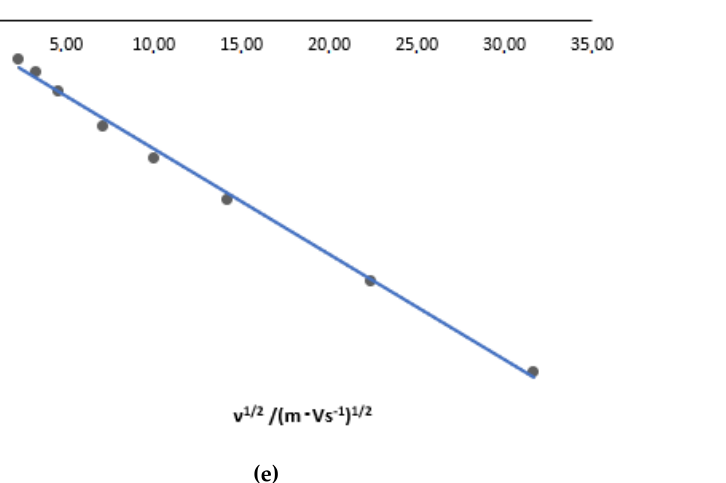
Figure 5. ( a ) Cyclic voltammograms of 1 × 10 − 3 mol dm − 3 Bi(III) at different scan rates recorded in 1 mol dm − 3 chlorate(VII) solution in the absence of the methionine. The scan rate ( v ) values are given on the plots. ( b ) Cyclic voltammograms of 1 × 10 − 3 mol dm − 3 Bi(III) at different scan rates recorded in 1 mol dm − 3 chlorate(VII) solution in the presence of 1 × 10 − 3 mol dm − 3 methionine. The scan rate ( v ) values are given on the plots. ( c ) The dependence of the cathodic peak current for the reduction of Bi(III) ( I p ) on the square root of the scan rate ( v 1/2 ). Each point is an average of three measurements. ( d ) The log–log dependence of the reduction peak current and the scan rate over the interval from 5 to 1000 mV s − 1 (in the absence of the methionine). Each point is an average of three measurements. ( e ) The dependence of the cathodic peak current for the reduction of Bi(III) + 1 × 10 − 4 mol dm − 3 methionine ( I p ) on the square root of the scan rate ( v 1/2 ). Each point is an average of three measurements. ( f ) The log-log dependence of the reduction peak current and the scan rate over the interval from 5 to 1000 mV s − 1 (in the presence of 1 × 10 − 3 mol dm − 3 methionine). Each point is an average of three